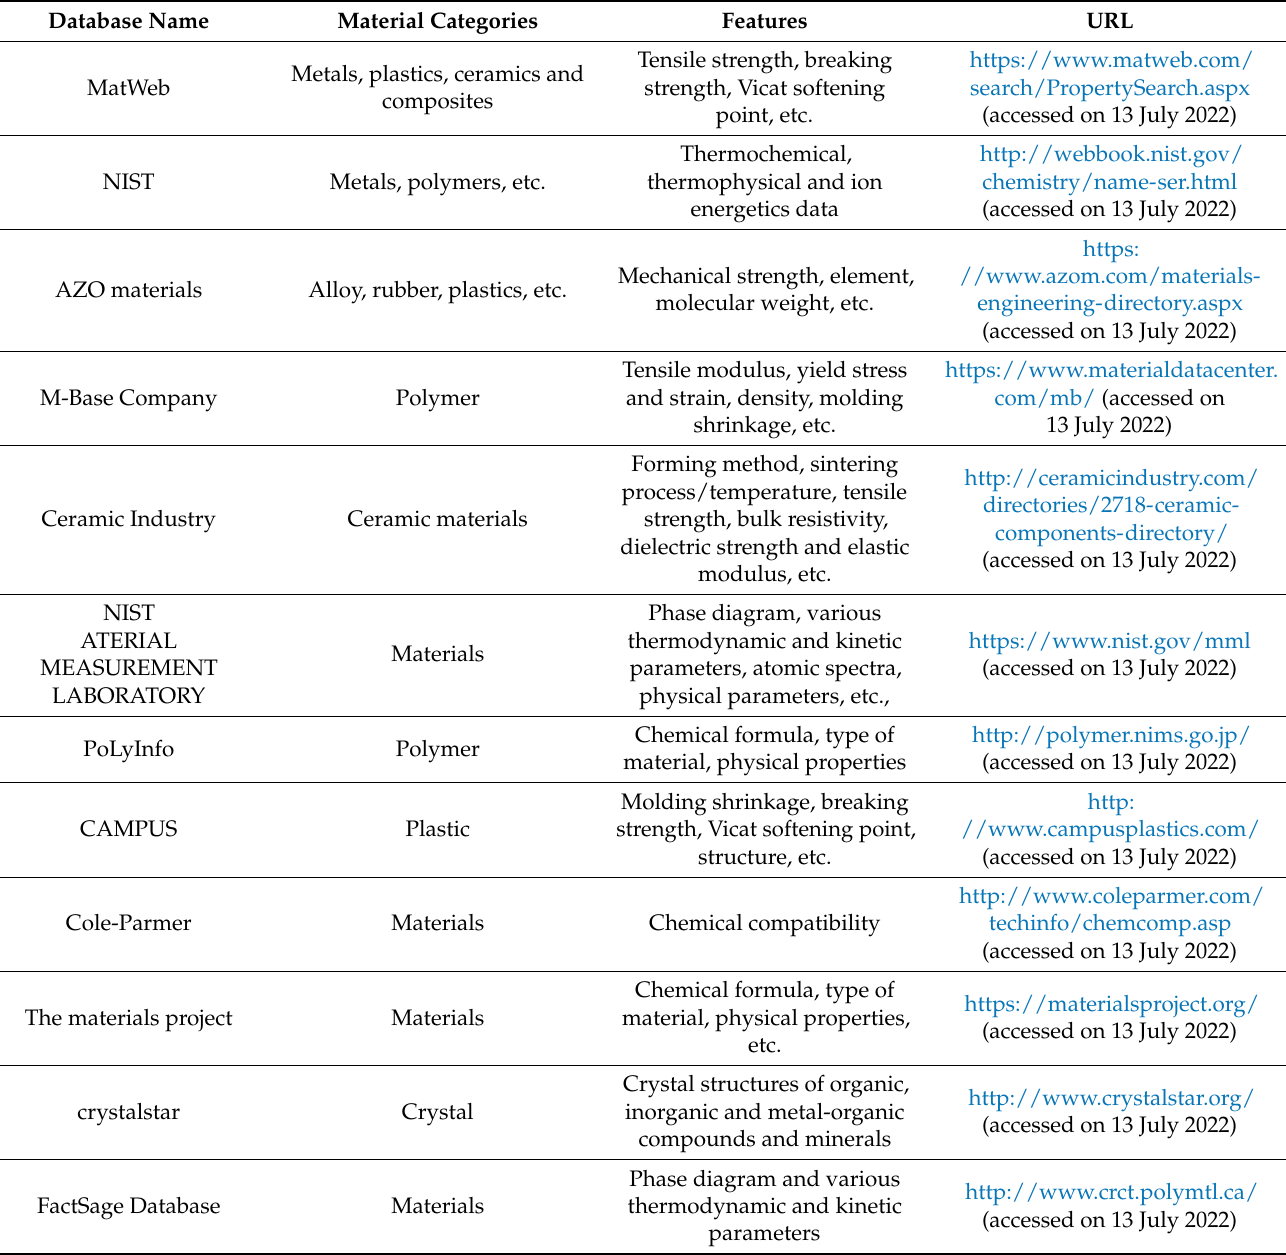
Table 1. Popular databases in performance prediction of